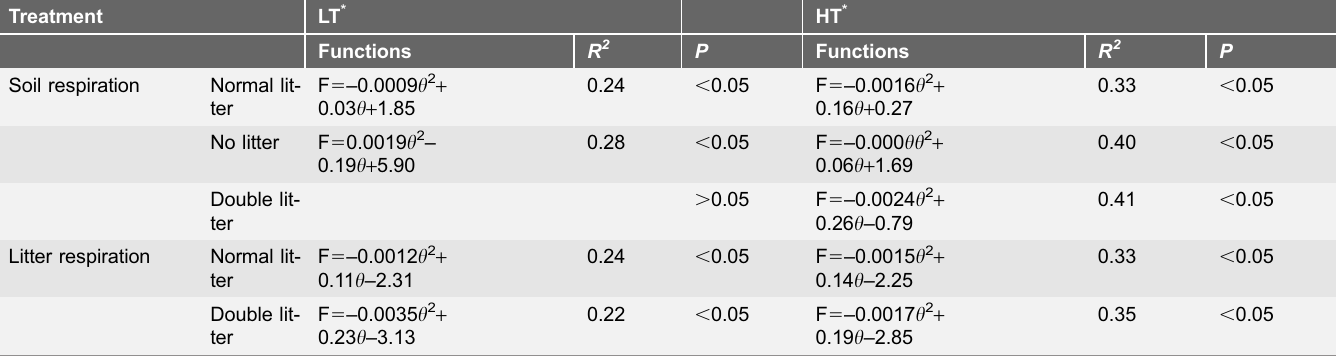
Table 4. A quadratic regression function was used to describe the relationship between soil respiration (F), soil moisture ( h ), and litter respiration (F), under normal, no litter, and double litter treatments.